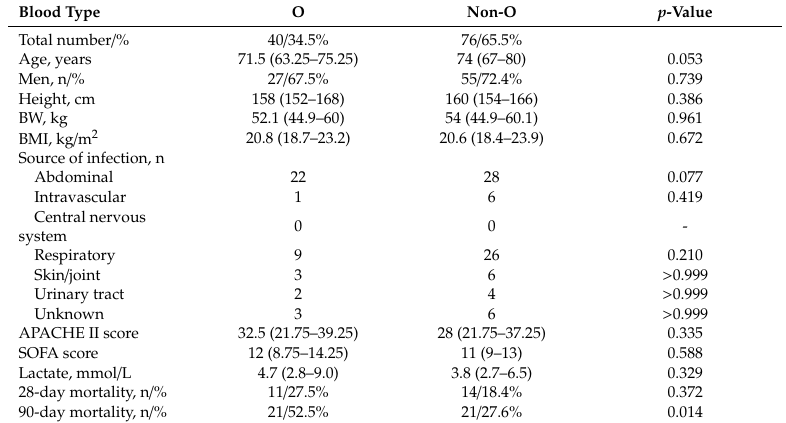
Table 3. Baseline characteristics of patients with blood type O and others in the septic shock